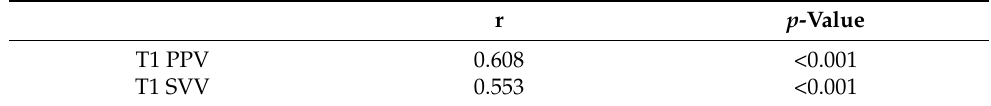
PPV, pulse pressure variation; SVV, stroke volume variation.